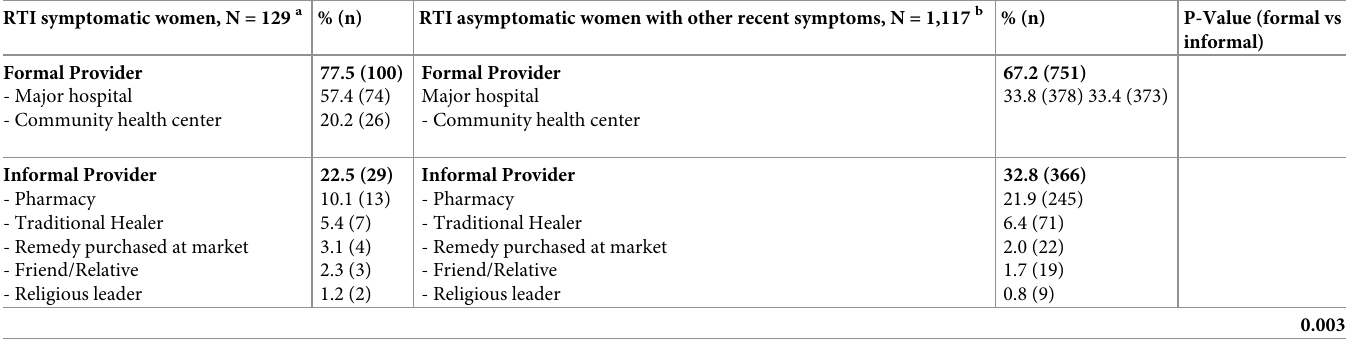
Table 5. Care provider sought for RTI symptoms among RTI symptomatic women vs. RTI asymptomatic women seeking care for other recent non-RTI symptoms. RTI symptomatic women, N = 129 a % (n) RTI asymptomatic women with other recent symptoms, N = 1,117 b %